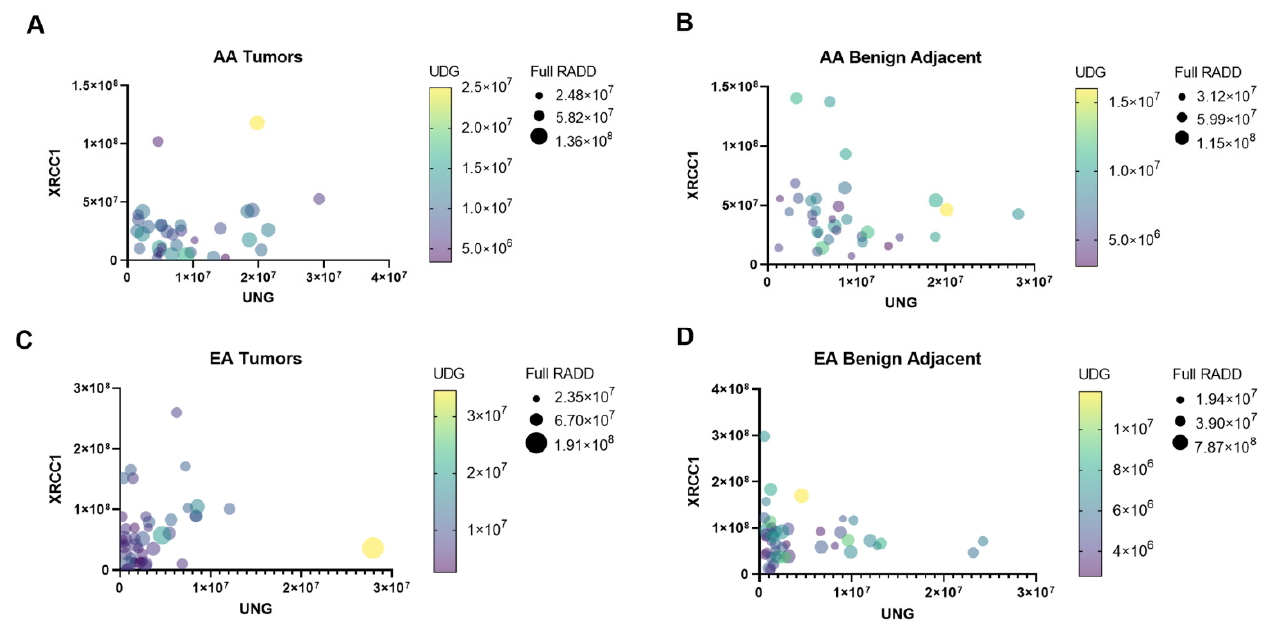
Figure 4. DNA repair protein expression and damage profiles show unique signatures between AA and EA tumor and benign-adjacent samples. Multiple variable graphs of XRCC1 versus UNG expression in AA tumor ( A ), AA benign-adjacent ( B ), EA tumor ( C ), and EA benign-adjacent ( D ). The symbol color intensity corresponds to the uracil damage content (UDG RADD), while the symbol size reflects the overall DNA damage content (Full RADD).